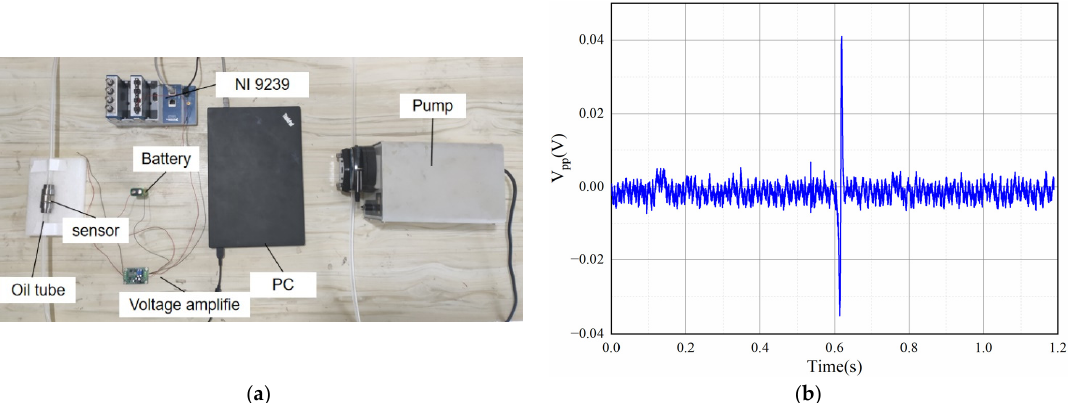
Figure 17. Lube oil experiment: ( a ) wear debris monitoring test bench; ( b ) results obtained from the oil experiment.